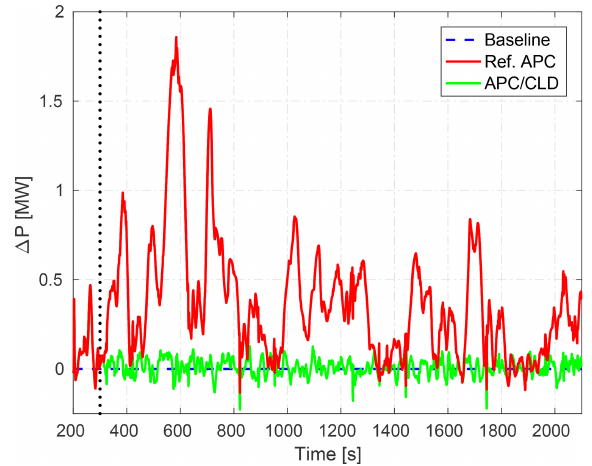
Figure 14. The control signal (cid:49)P ref for adjustment of the wind turbine power demands.